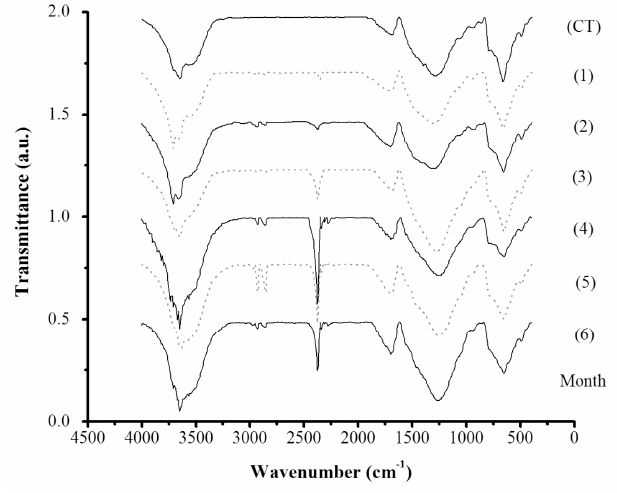
Figure 8. Infrared spectra of tezontle PS1 with biofilm development by month and clean tezontle (CT).